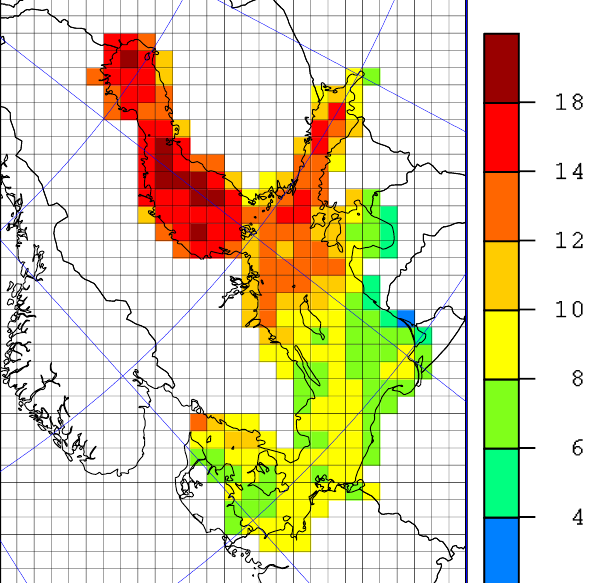
Fig. 14 . Map of coefficient of variation (over the period 1995 – 2006) of total nitrogen Fig. 14. Map of coefficient of variation (over the period 1995–2006) deposition to the Baltic Sea basin. Deposition is calculated with constant emissions from 2006 of total nitrogen deposition to the Baltic Sea basin. Deposition is and variable meteorology for all years. Coefficient of variation is expressed in % of average calculated with constant emissions from 2006 and variable meteo- deposition for each model grid square. rology for all years. Coefficient of variation is expressed in % of average deposition for each model grid square.